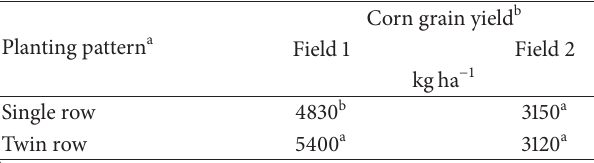
Table 4: Influence of planting pattern on corn grain yield during 2012 at Lewiston-Woodville.